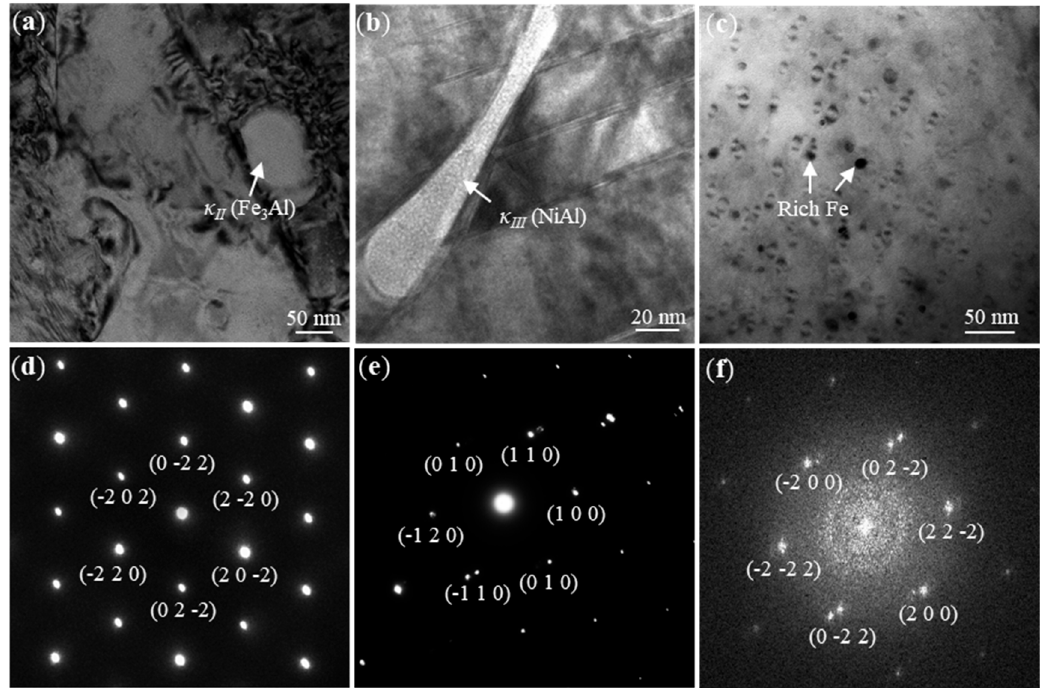
Figure 10. TEM-bright field micrographs images and selected area di ff raction pattern: ( a ) κ II precipitates (Fe 3 Al) in the interdendritic, ( b ) κ III precipitates (NiAl) in the interdendritic, ( c ) κ IV precipitates (Fe-rich) in α -Cu matrix, ( d – f ) corresponding selected area di ff raction pattern Fe 3 Al, NiAl and Fe-rich, respectively.